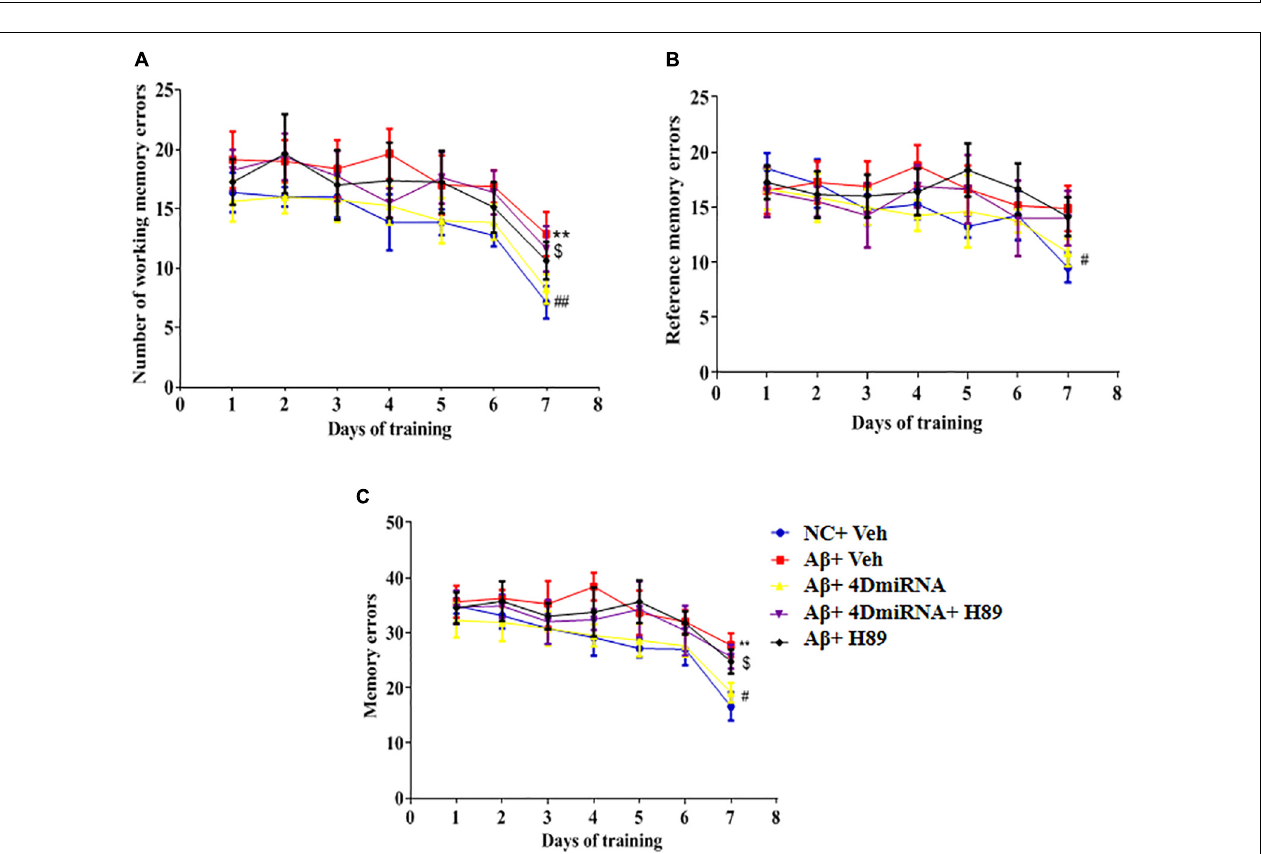
FIGURE 4 | PDE4D deficiency improved memory in the eight-arm maze test in A β 1–42-treated mice. The working memory errors, (A) reference memory errors, (B) and the total memory errors (C) were recorded after microinjection of lenti-PDE4D-miRNA into the prefrontal cortex. Values were the means ± SEM with 12 mice in each group. ** P < 0.01 vs. control group (NC); # P < 0.05, ## P < 0.01 vs. A β +Veh group; $ P < 0.05 vs. A β +4DmiRNA